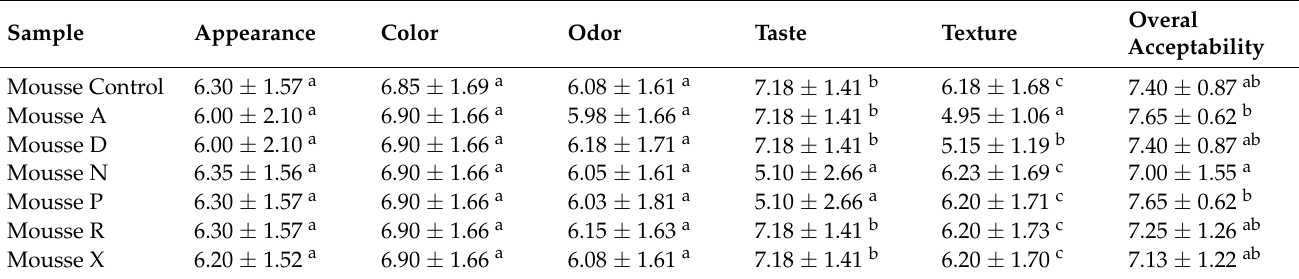
Table 10. Sensory properties of chocolate